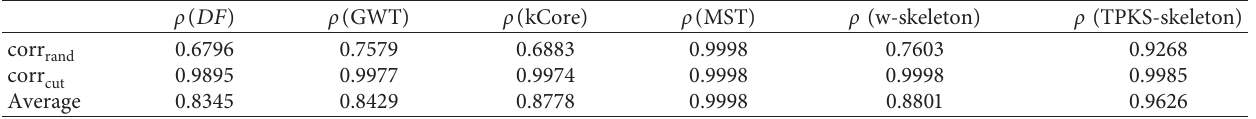
Table 3: The Spearman rank correlation ρ (·) of the corresponding skeleton network extraction